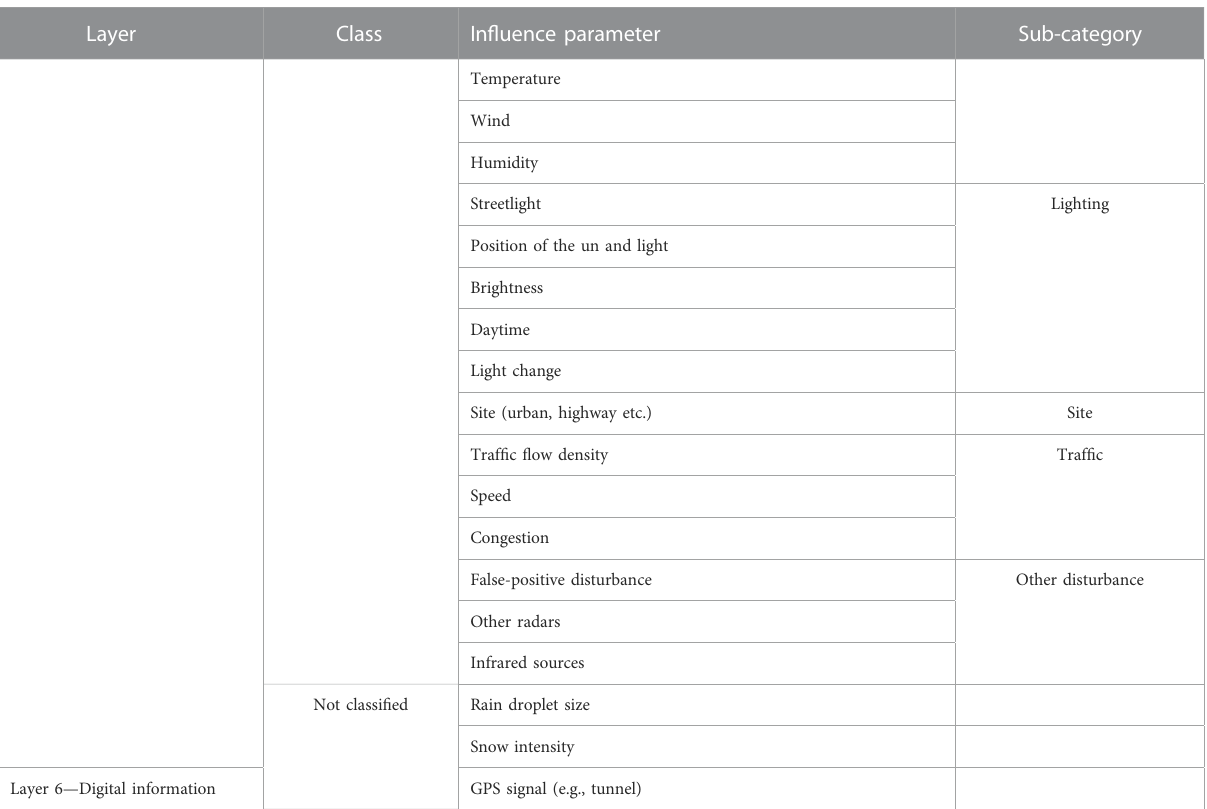
TABLE 7 ( Continued ) In fl uence parameter list with categorization and classi fi